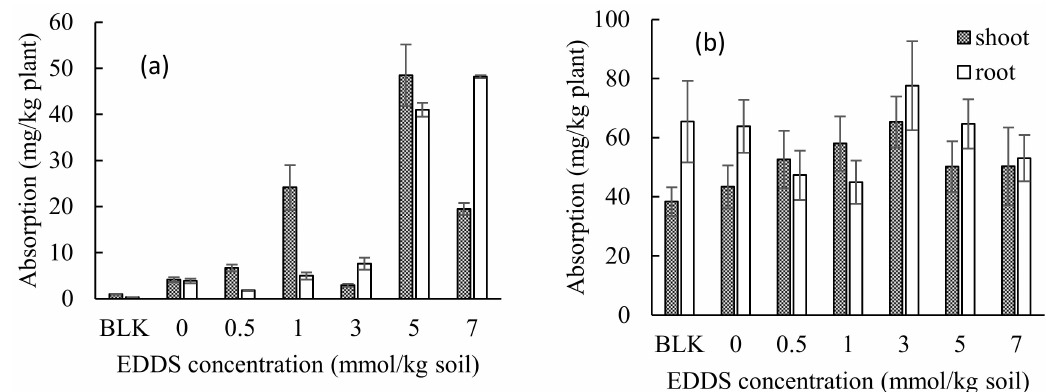
Figure 2. Effect of the EDDS concentration on the adsorption of ( a ) Cd ( b ) Zn by Taracum officinale (70% humidity). BLK represents the pot for no addition of heavy metals (i.e., Cd and Zn) as well as no addition of EDDS (i.e., Pot No. 1 in Table 1).